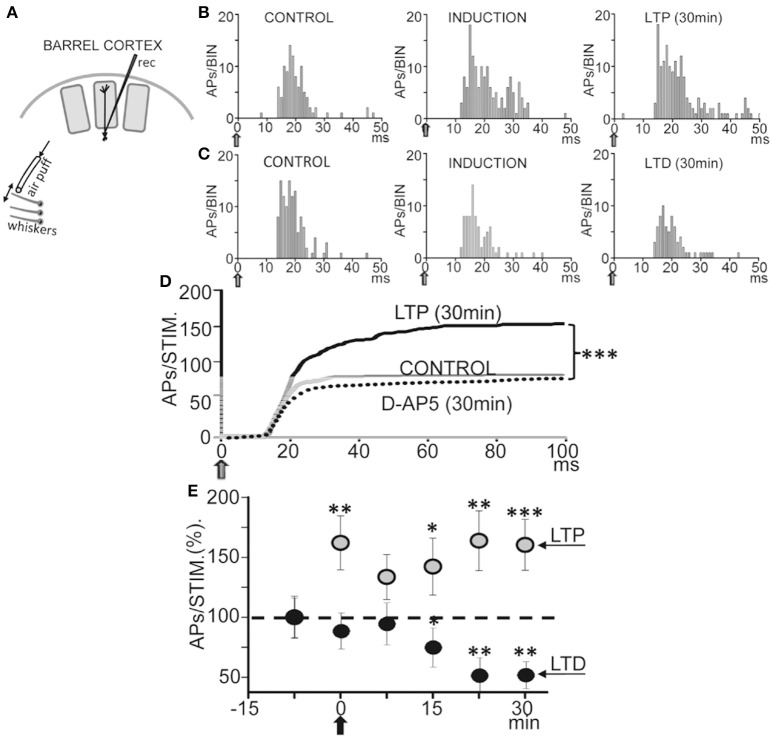
Bidirectional plasticity evoked by whisker deflections in anesthetized rats. (A) Schematic diagram of experimental setup. (B) Representative PSTHs computed during whisker deflections (gray arrows) in CONTROL (0.5 Hz), INDUCTION (1.0 Hz), and LTP (0.5 Hz) conditions. Note the increase in the number of APs during induction and the LTP 30 min after. (C) Same as (B), but the number of APs was reduced 30 min after INDUCTION, or LTD, and APs did not increase during induction. (D) Cumulative spike plots (CSP) computed by averaging all PSTHs (see Materials and Methods) in CONTROL, LTP (N = 16, P < 0.001) and under an injection of D-AP5 (50 μM; 0.1 μl, N = 14, P < 0.001) in L5 (see Materials and Methods). Note the enhanced whisker-evoked response during LTP and the reduced response with D-AP5. Blockade of NMDARs by injections of D-AP5 inhibited plasticity. (E) Plot showing averaged responses vs. time before and after induction (black arrow). Data points represent the mean area of PSTHs (CSPs;% of controls) computed over 5 min showing LTP (gray circles, N = 16, P < 0.001) and LTD (black circles, N = 5, P < 0.01).